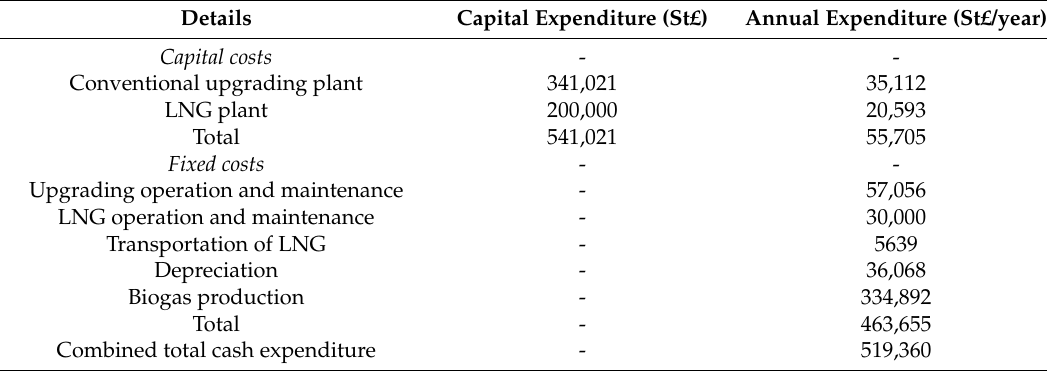
Table A5. Expenditure for conventional upgrading of biogas for use as LNG (routes